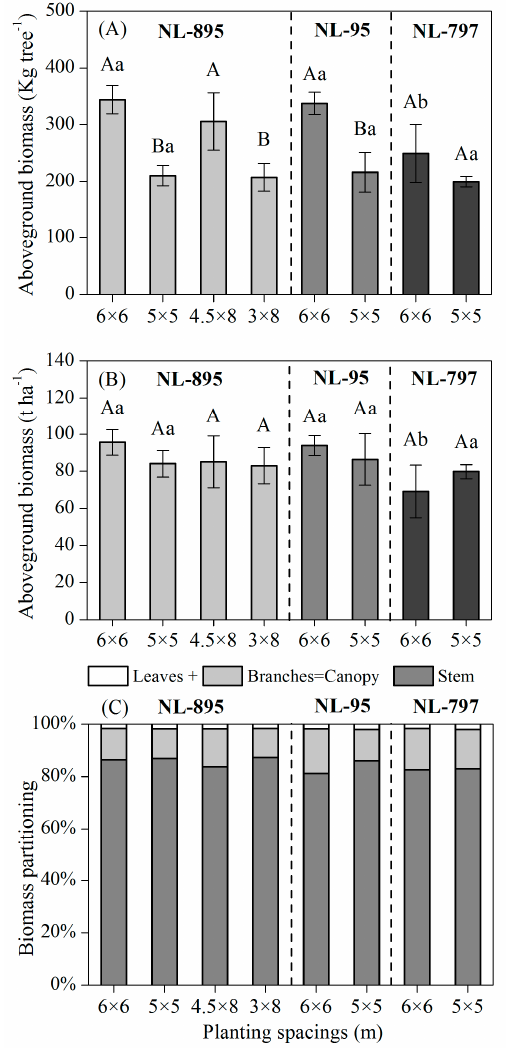
Figure 2. Effects of poplar clones and planting spacings on aboveground biomass of per sample tree ( A ) and per hectare ( B ) in 13-year-old poplar plantations. Different capital letters indicate significant differences ( p < 0.05) by Tukey test between planting spacings for each clone, and different small letters indicate significant differences ( p < 0.05) by Tukey test between clones within each planting spacing. Last is the biomass partitioning of poplar in eight treatments ( C ). The error bars indicate the standard error.